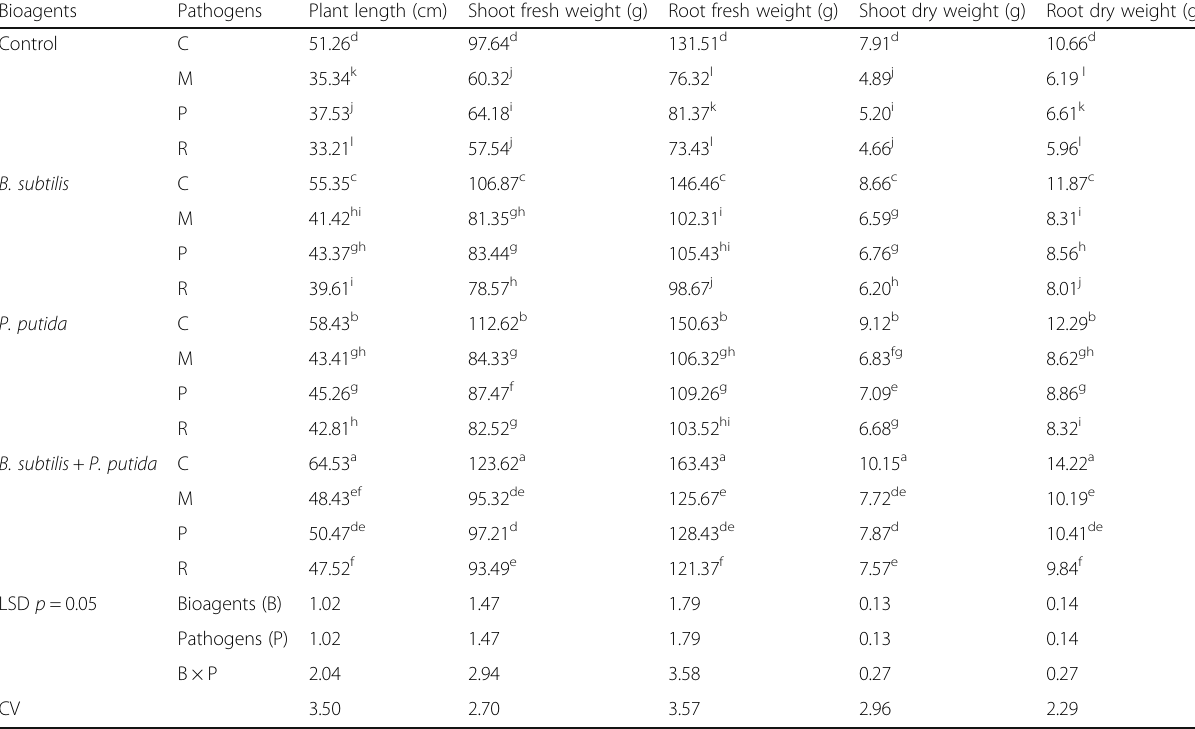
Table 1 Influence of Pseudomonas putida , Bacillus subtilis , and their mixtures on the plant length, shoot fresh weight, root fresh weight, shoot dry weight, and root dry weight of beetroot infected with Meloidogyne incognita , Pectobacterium betavasculorum , and Rhizoctonia